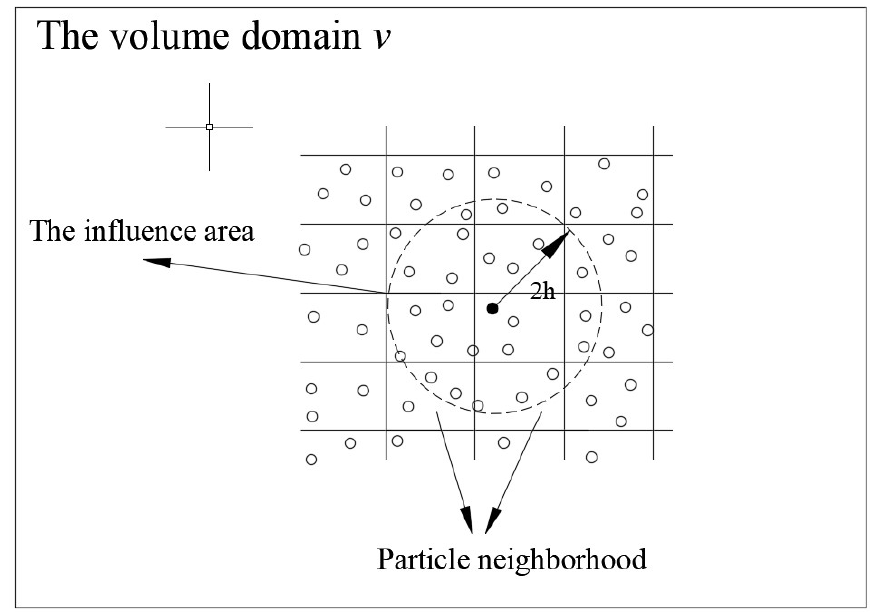
Figure 1. The domain search of the SPH method.